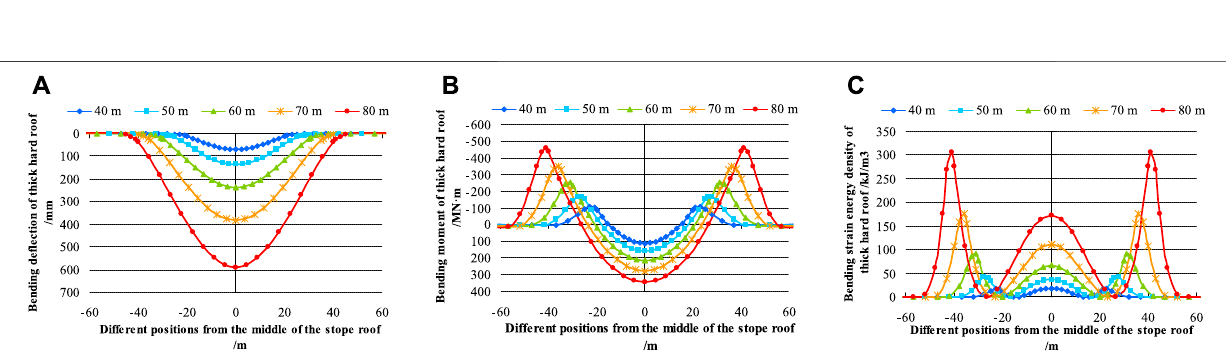
Frontiers in Earth Science |